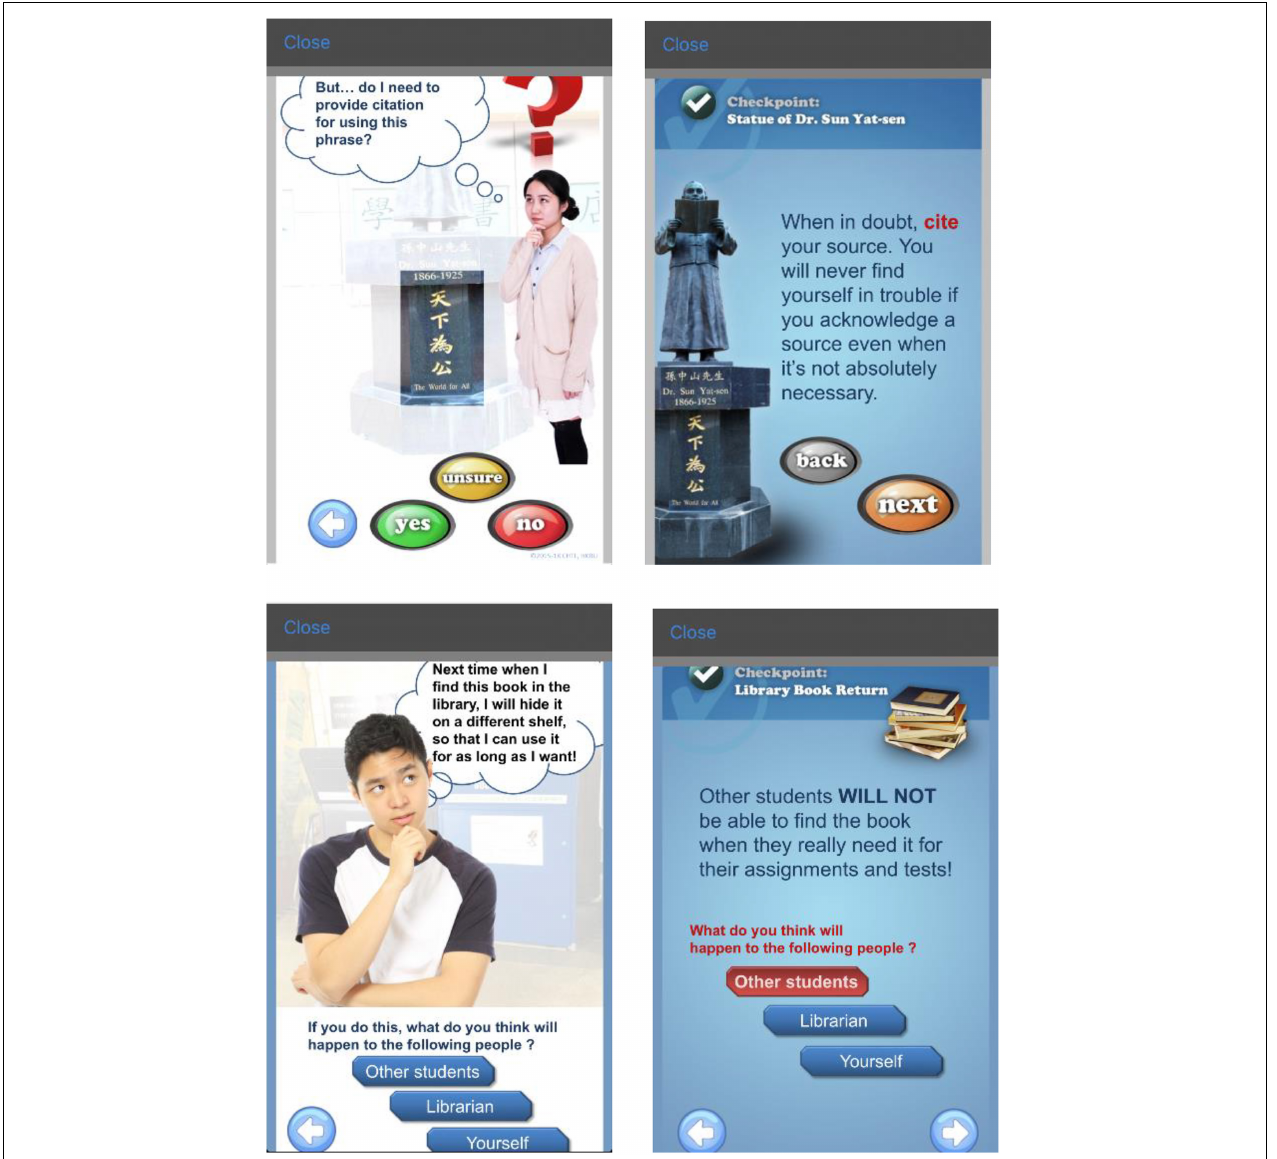
FIGURE 1 | Screenshots of the TIE-general learning trail (Scenarios of Citation and Library